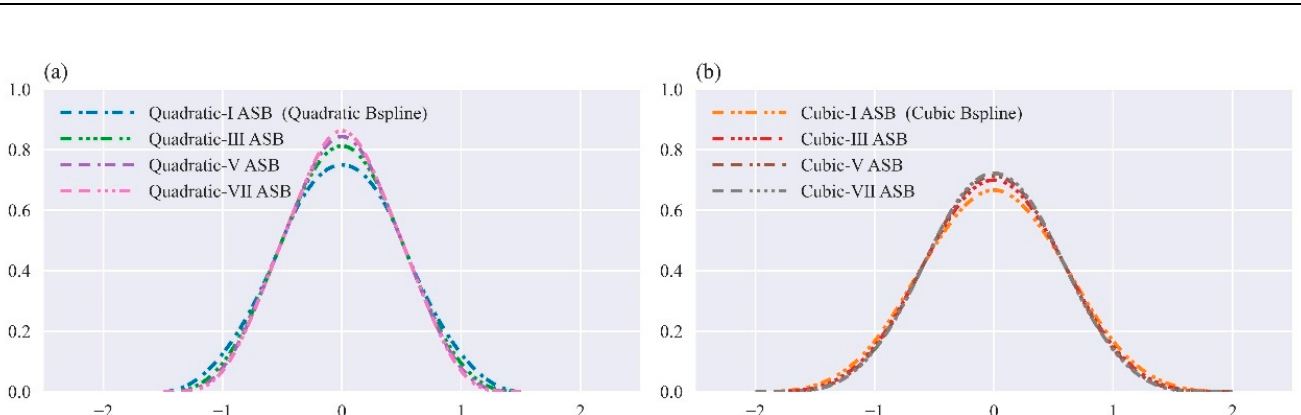
quired in ASBMPM variants.